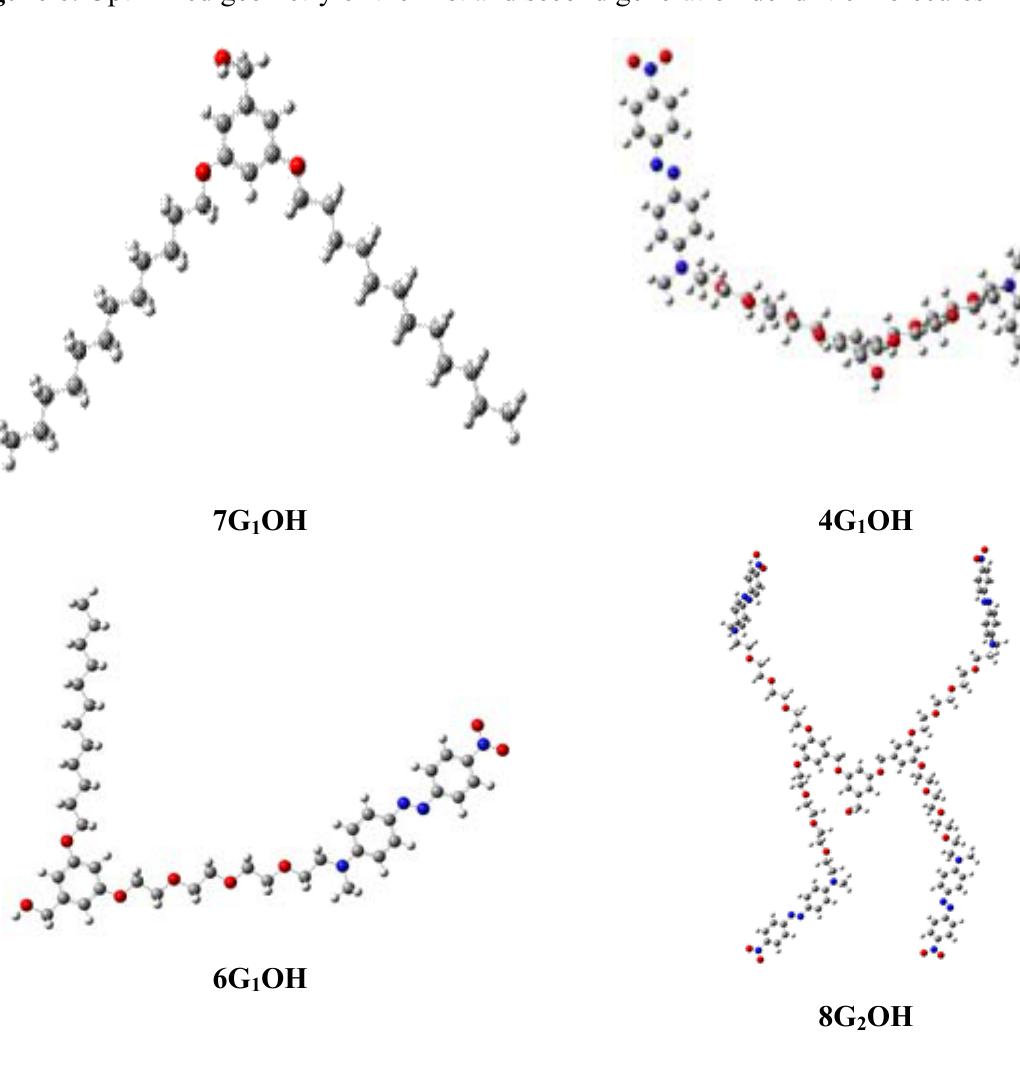
Figure 6. Optimized geometry of the first and second generation dendritic molecules in